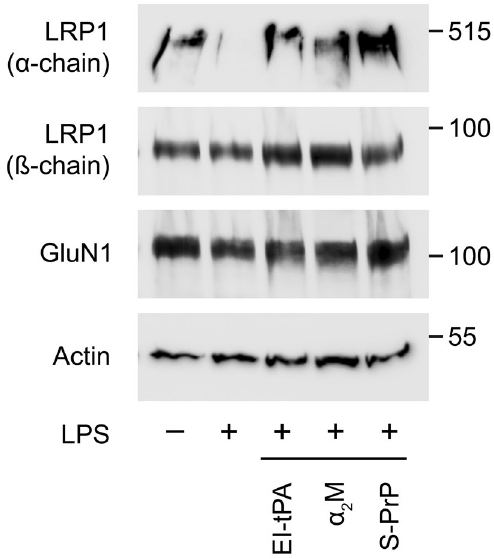
Figure 7. EI-tPA, α 2 M, and S-PrP prevent the decrease in cellular LRP1 α-chain caused by LPS. BMDMs were treated with LPS (0.1 µg/ml) alone and together with EI-tPA (10 nM), α 2 M (10 nM), or S-PrP (40 nM) for 6